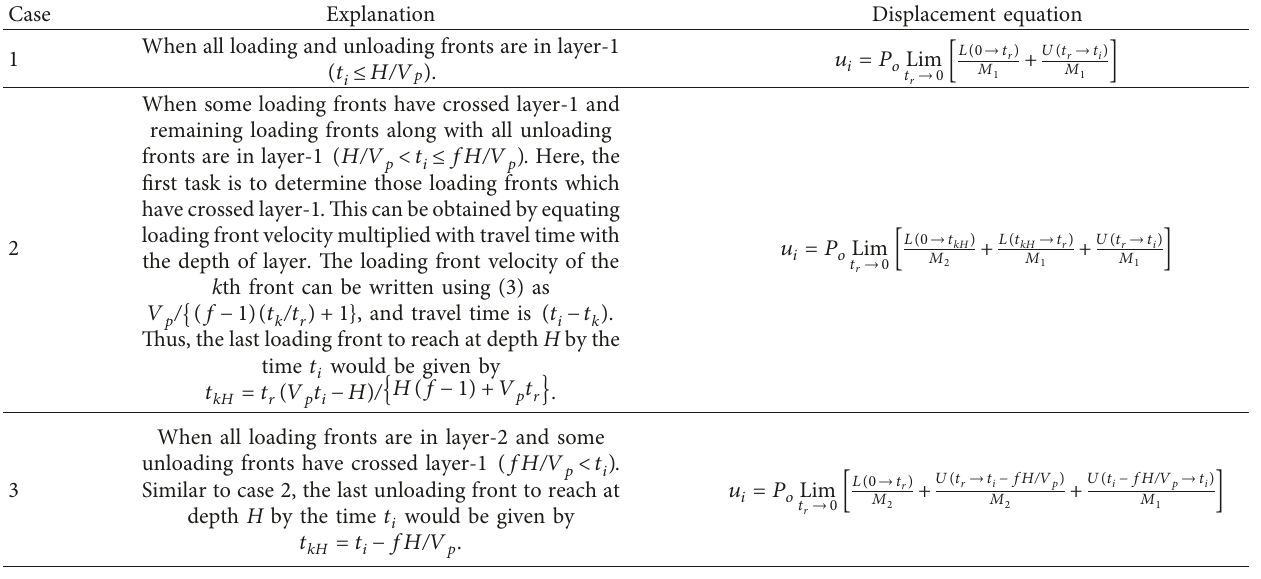
Table 1: Displacement solutions for the double-layered media.